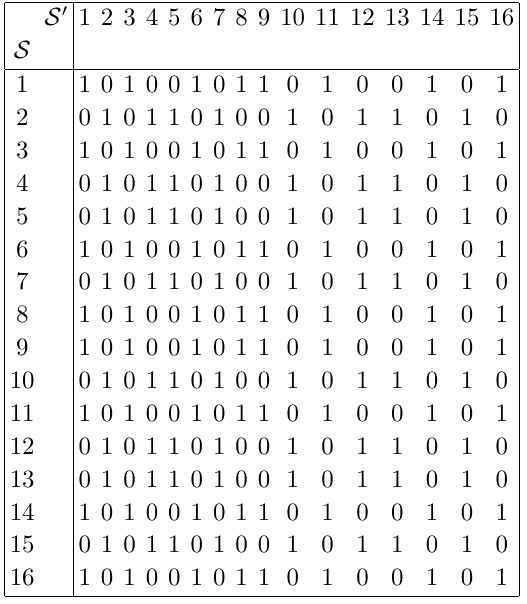
Table 32 . Gadget values for P